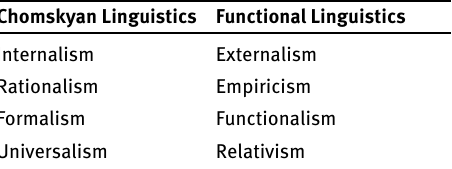
Table 1: Two types of linguistics in